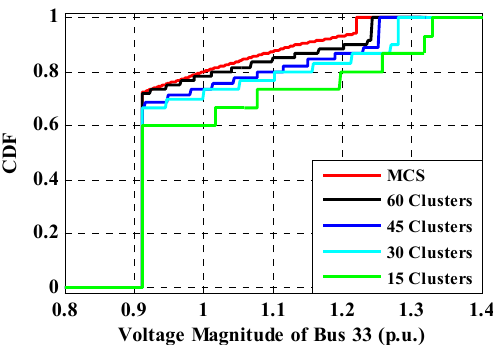
Figure 10. Cumulative distribution function of voltage magnitude for bus-33.